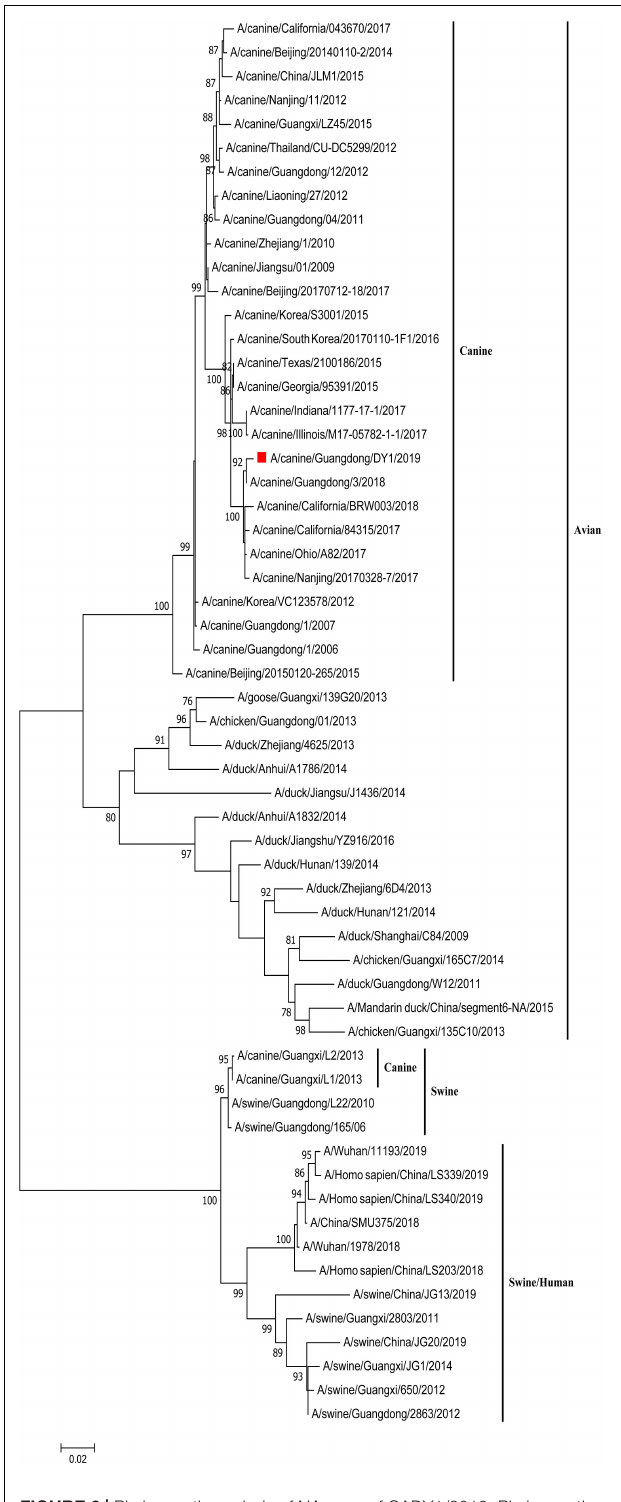
FIGURE 2 | Phylogenetic analysis of NA gene of CADY1/2019. Phylogenetic trees for whole gene segments of CADY1/2019 created with 1000 bootstrap replicates using MEGA 7.0 software. Solid red square indicated CADY1/2019 in each phylogenetic tree. Phylogenetic trees of NA genes based on nt